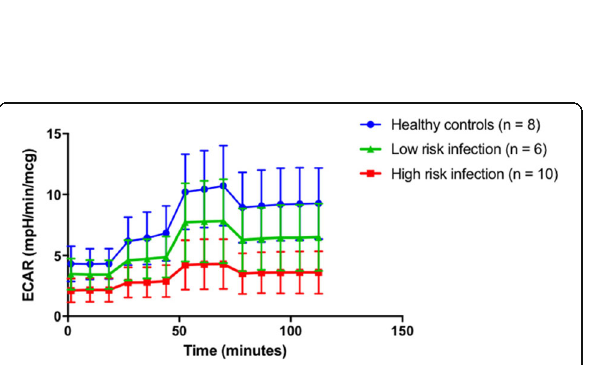
Fig. 2 (abstract P49). Extracellular acidification rate (ECAR)-time plot as measured by Seahorse assay in healthy controls, low and high risk infection group. ECAR represents cellular metabolism through glycolysis. Seeing no difference in total ROS production across the three groups (Fig. 3), indicating that oxidative stress did not play a role in reducing mitochondrial respiration in PBMC of high risk infection groups.